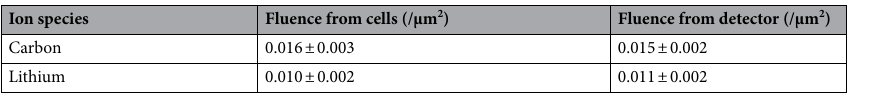
Table 2. Fluence for carbon and lithium ion irradiation determined either from the cells or by the PMT